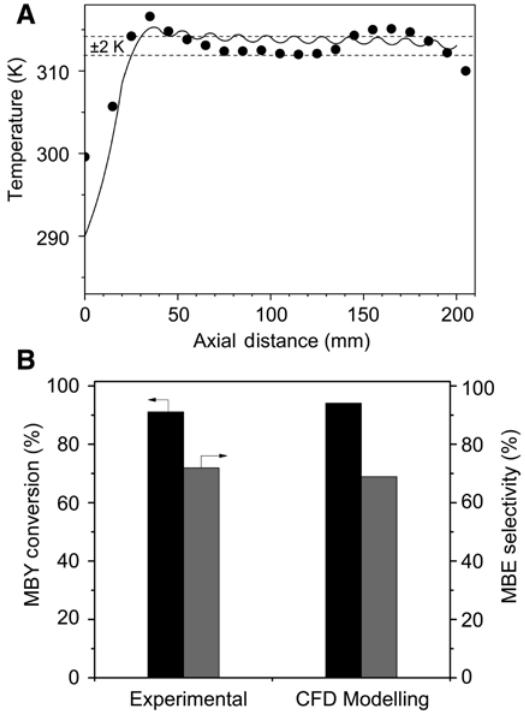
Figure 6: (A) Measured (symbols) and predicted (line) temperature along the center axis in the 11 zone R-5 reactor. (B) Measured and predicted 2-methyl-3-butyne-2-ol (MBY) conversion and 2-methyl- 3-butene-2-ol (MBE) selectivity in the 5 catalytic zone R-5 reactor. Reaction conditions are the same as those in Figure 2.